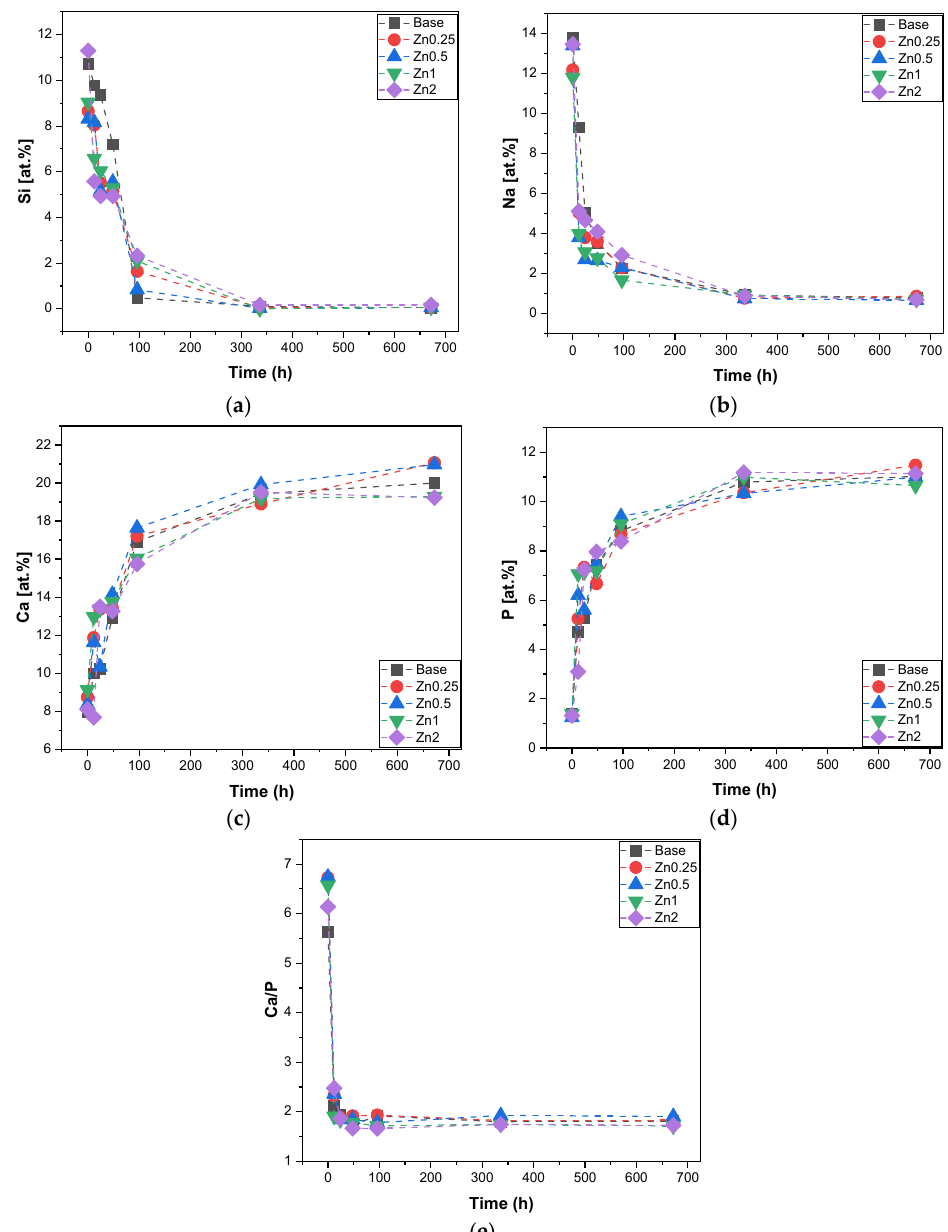
Figure 5. EDS results of the pellet’s surface after SBF immersion for 12 h, 24 h, 48 h, 96 h, 336 h and 672 h. ( a ) Si at.%; ( b ) Na at.%; ( c ) Ca at.%; ( d ) P at.% and ( e ) ratio between Ca at.% and P at.%. The morphology of the Base and Zn2 samples’ surface after immersion in SBF for 24 h, 96 h and 672 h was observed with SEM as shown in Figure 6. The images reveal that there is a deposition of particles with spherical morphology on the surface of the samples from 24 h, increasing in quantity and size over the time of immersion in SBF. The Zn2 sample shows no significant differences compared to the base in agreement with the EDS results. After 24 h of immersion, the base and Zn2 samples present particle size diameters between 200–400 nm and 300–600 nm, respectively. After 96 h, the presence of agglomer- ates is remarkable in both samples, and the filled layer rich in Ca/P is visible in the base